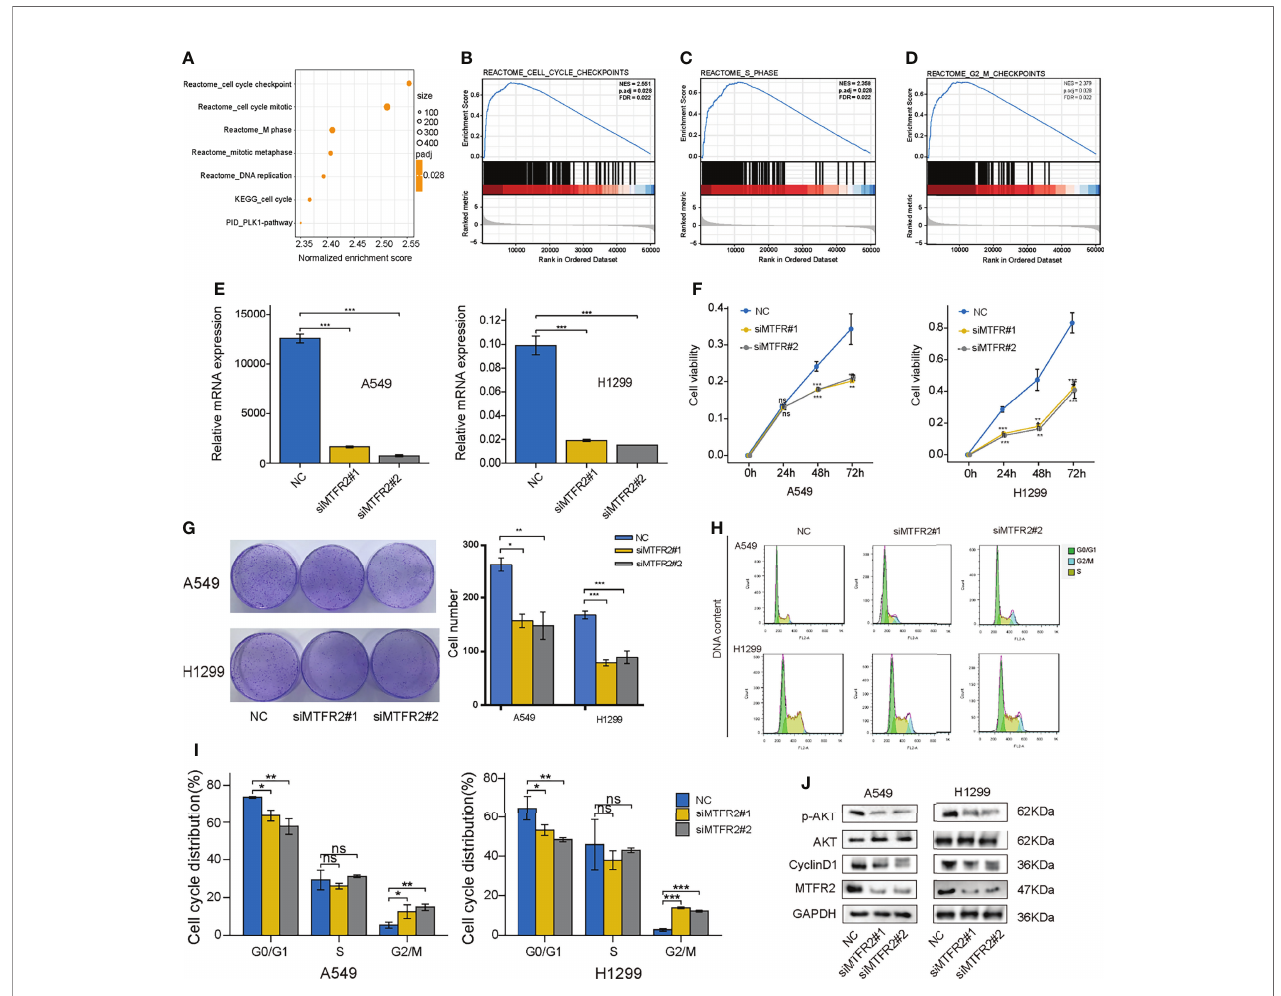
FIGURE 4 | Knockdown of MTFR2 inhibited cell proliferation via the AKT signaling pathway. GSEA analysis showed that a high MTFR2 expression was associated with the cell cycle-related pathway (A – D) . qRT-PCR indicated that MTFR2 expression levels were decreased after knockdown of MTFR2 in A549 and H1299 cells (E) . CCK-8 assay (F) and cell colony (G) showed that cell proliferation were inhibited. Cell cycles were arrested in A549 and H1299 cells (H, I) . Western blot assay indicated that knockdown of MTFR2 downregulated the p-AKT and cyclin D1 expression levels (J) . * P < 0.05, ** P < 0.01, *** P < 0.001, ns, no statistical signi fi cance. ES, enrichment score; NES, normalized